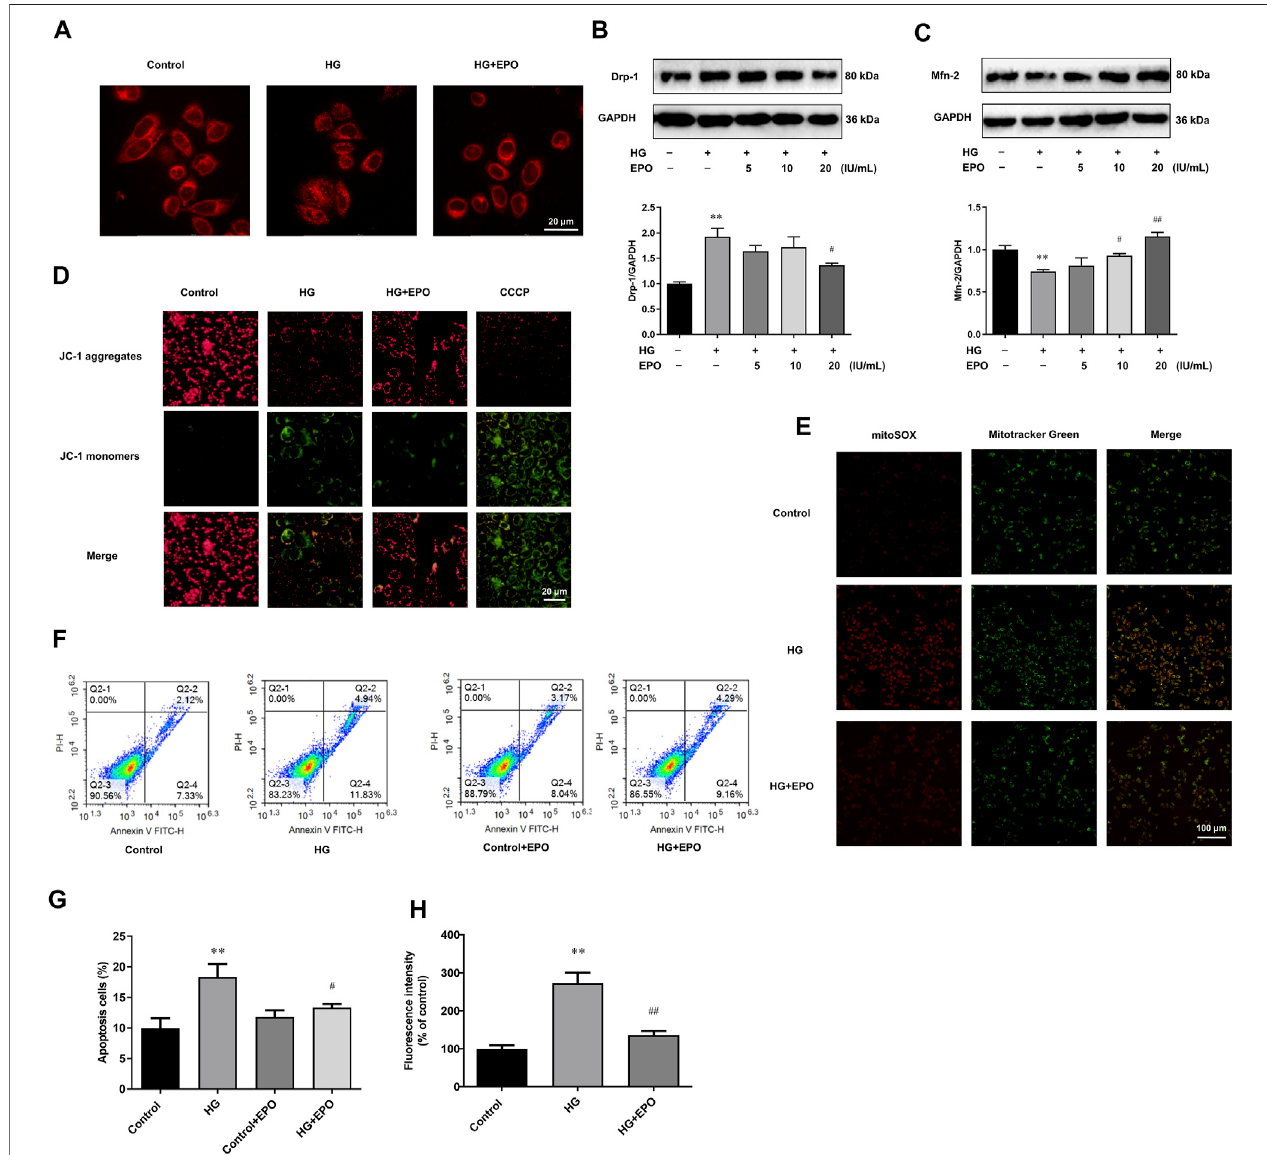
FIGURE 2 | EPO alleviated mitochondrial dysfunction and apoptosis in mesangial cells exposed to HG. (A) Representative images of mesangial cells stained with Mitotracker-Red. Representative immunoblots and quanti fi cation of (B) Drp-1 and (C) Mfn-2. Representative images of mesangial cells stained with (D) JC-1 and (E) MitoSOX as well as (G) quanti fi cation of the level of mitochondrial ROS. (F) Flow cytometry analysis and (H) quantitative analysis of cell apoptosis. Values are presented as mean ± SEM, n = 3. ** p < 0.01 vs. Control group; # p < 0.05, ## p < 0.01 vs. HG